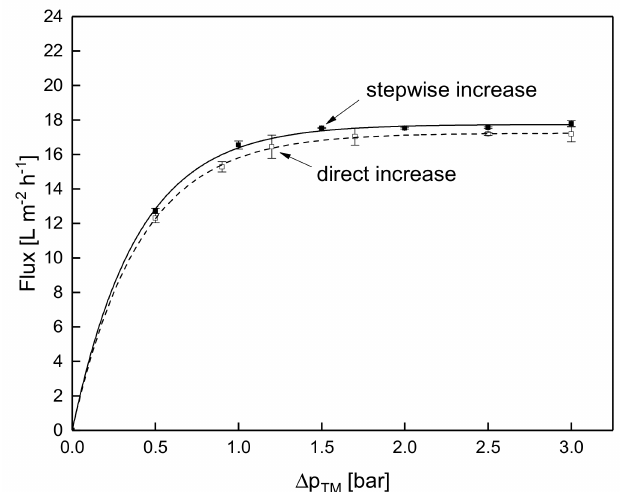
Figure 4. Comparison of flux after a stepwise (filled symbols and solid line) and a direct ∆ p TM increase to target level (blank symbols and dashed line) at 10 ◦